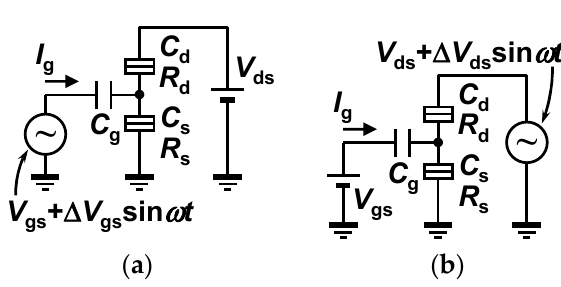
Figure 2. Circuit diagrams for the measurement of ( a ) C gg and ( b ) C gd .